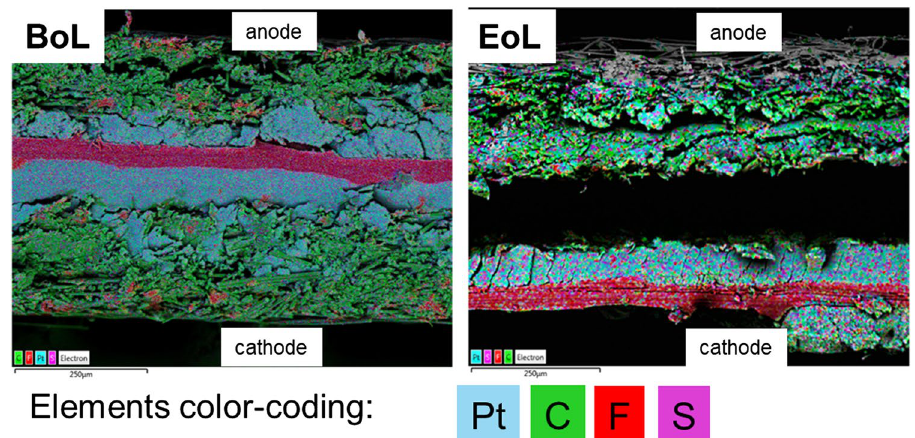
Fig. 10 HR-SEM/EDS layered image of MEA’s cross-section before (BoL) and after (EoL)